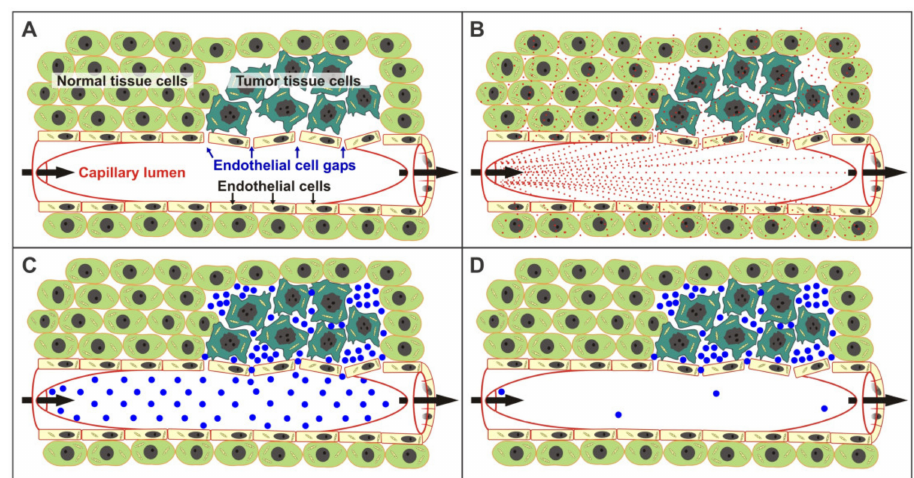
Figure 1. Illustration of the enhanced permeability and retention (EPR) effect, a verified phenomenon exclusive to solid tumors ( A ) Solid tumors, unlike normal tissues, have large gaps between the capillary endothelial cells permitting large scale extravasation and retention of macromolecules. ( B ) Small permeable molecules represented by small red dots readily traverse the endothelial cells lining capillary walls and penetrate both normal and tumor tissues. ( C ) Large membrane impermeable macromolecular prodrug (MW ~ 70 kDa) essentially confined to the plasma volume except in tumor tissues where the abnormally leaky vascular networks result in large molecules concentrating within the extracellular space. ( D ) Macromolecular prodrug molecules are retained at high levels in the extracellular tumor space long after concentrations within the plasma have